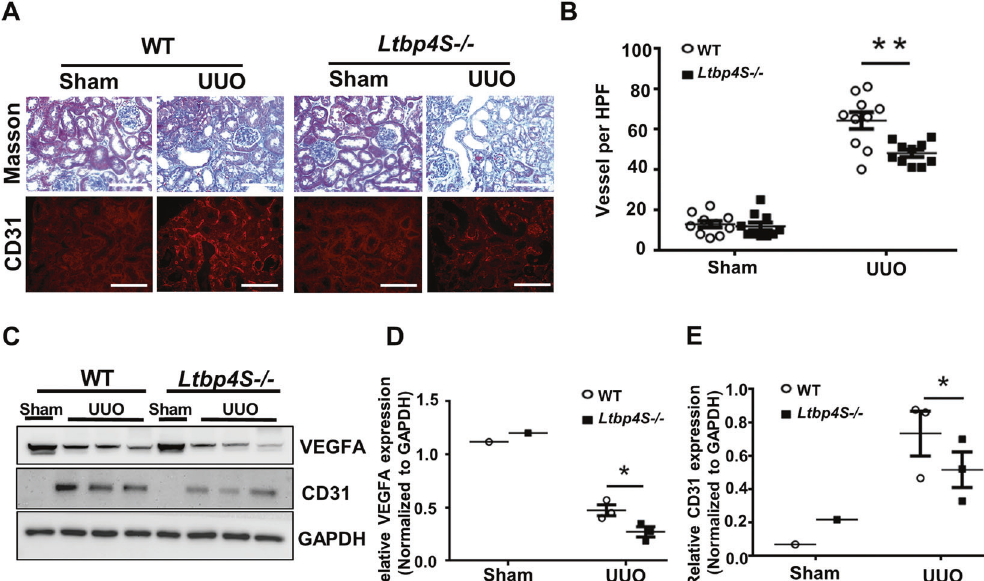
Fig. 5 LTBP4 induces angiogenesis for kidney repair in mice subjected to unilateral ureteral obstruction (UUO). Tubulointerstitial fi brosis was induced by UUO for 5 days in wild-type (WT) and Ltbp4 knockout ( Ltbp4S − / − ) mice. A Representative histological images with Masson ’ s trichrome and immuno fl uorescence staining of kidneys for CD31 after UUO. Scale bars, 100 μ m. B Quantitative results of vessels per HPF in the mouse kidneys. C Protein expression of VEGF and CD31 in the kidneys of mice with UUO, as detected by using immunoblotting. GAPDH served as an internal control. D , E Densitometric analyses of immunoblot images for VEGF ( D ) and CD31 ( E ) are shown. Data are presented as the mean ± SEM for each group ( n = 3). * P < 0.05, ** P < 0.01, *** P < 0.001. Results representative of three independent experiments performed in